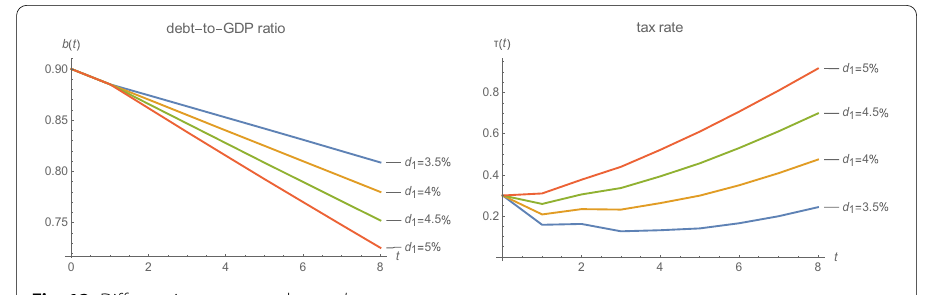
Fig. 12 Different income growth rate d